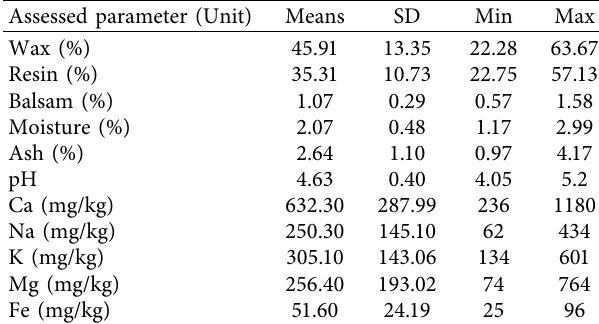
Table 2: Physicochemical characterization and mineral contents of the analyzed propolis